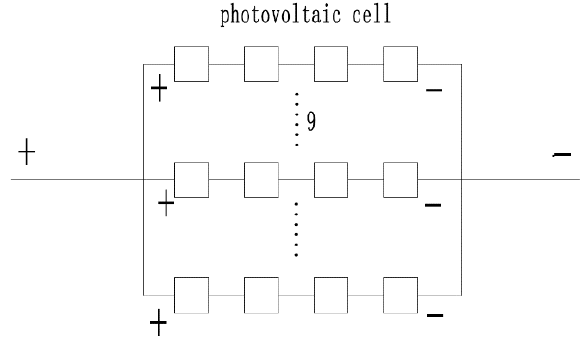
Figure 9. The circuit of photovoltaic panels.